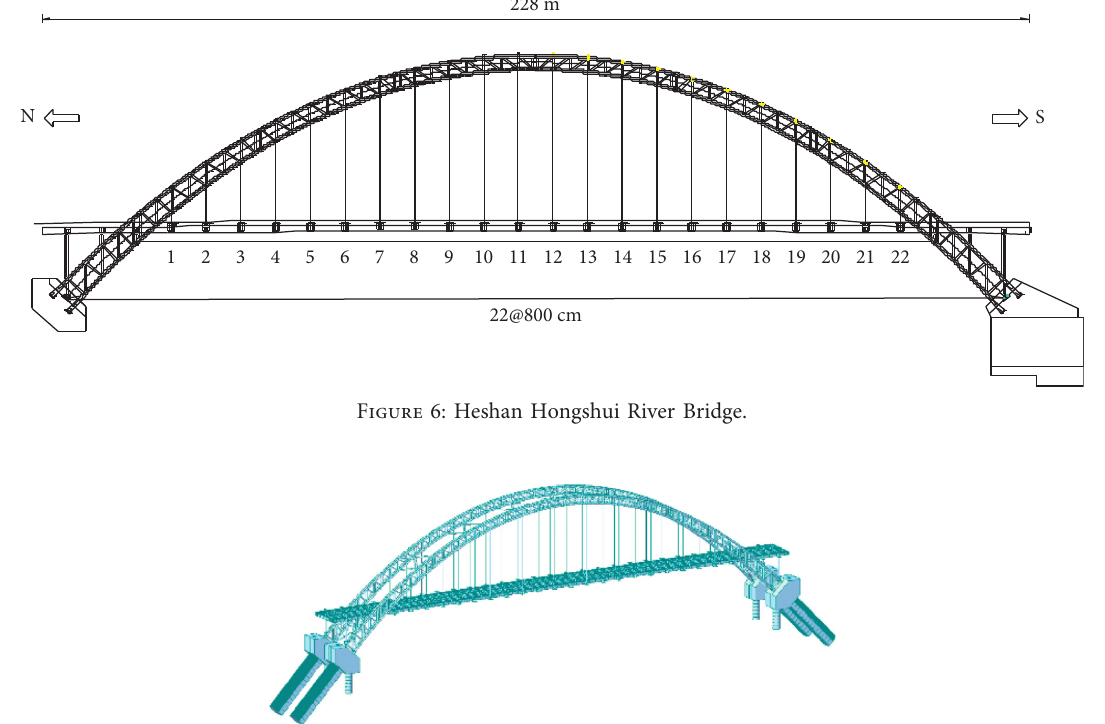
Figure 7: Finite element model of Heshan Hongshui River